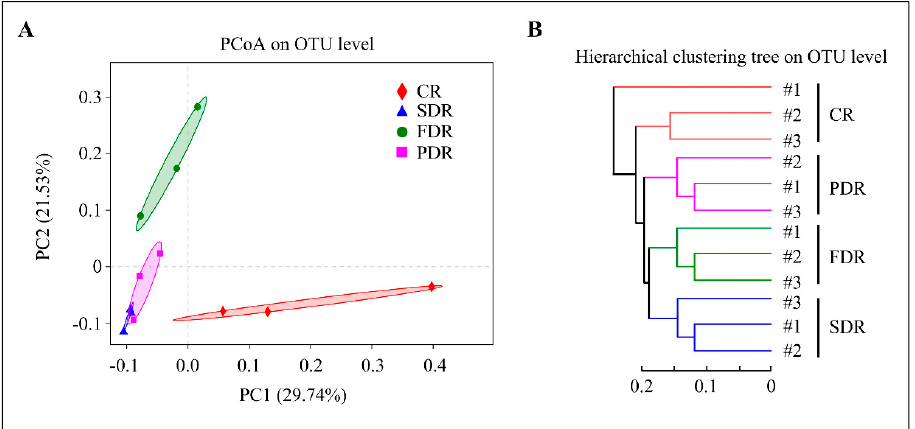
Figure 4. Beta diversity analysis. ( A ) Principal co-ordinates analysis (PCoA) analysis. The same color points belong to the same soil group, and the same soil group points are marked by ellipses. The samples belonging to the same soil group are closer to each other and the samples from different soil groups are farther apart. ( B ) Hierarchical clustering is clustered according to groups’ similarity. The branch length among soil groups represent the degree of similarity among the four soil groups. #1, #2 and #3 represent three duplicate samples in per soil group. The top 20 most abundant genera belonged to the phyla of Actinobacteria,